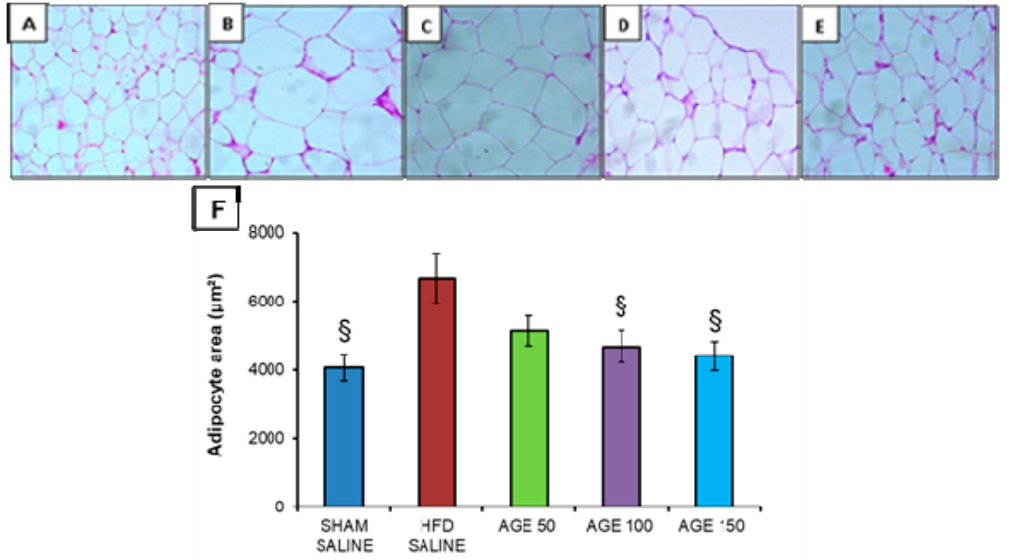
Figure 7. Histological analysis of the epididymal adipose tissue of each experimental group. ( A ) SHAM SALINE group. ( B ) HFD SALINE group. ( C ) AGE 50 mg / kg group. ( D ) AGE 100 mg / kg group. ( E ) AGE 150 mg / kg group. 20 × magnification. Bar scale: 100 µ m. (F) Adipocyte area ( µ m 2 ) of the groups studied. Values represent mean ± mean standard error. § p < 0.05 vs. HFD SALINE. ANOVA followed by post Tukey test.